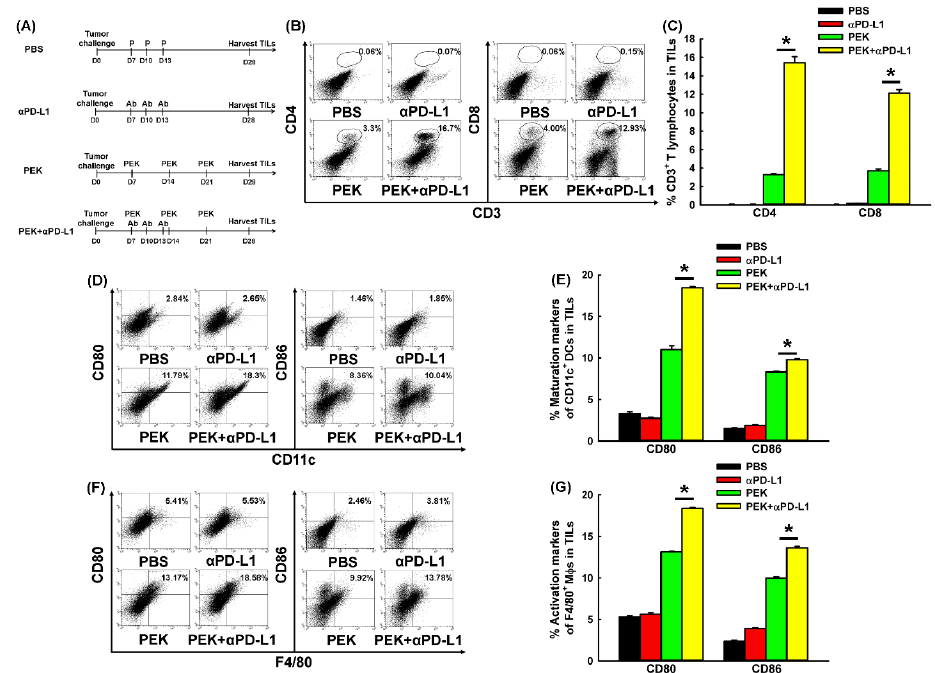
Figure 5. Alteration of T cells, DCs, and macrophages from tumor-infiltrating lymphocytes (TILs) of mice treated with PEK protein vaccine and/or anti-PD-L1 Ab. ( A ) Schematic diagram showed the obtained TILs from mice receving PEK protein vaccine with or without anti-PD-L1 Ab. ( B ) Representative figures depicting tumor-infiltrating CD4 + and CD8 + T lymphocytes from mice on day 28 after tumor challenge in various groups, as determined by flow cytometry. ( C ) Percentages of CD4 + and CD8 + T lymphocytes from mice on day 28 after tumor challenge in various groups, as determined by flow cytometry ( n = 5 per group, mean ± SEM). The percentage of CD4 + T lymphocytes was higher in tumors from mice treated with PEK protein vaccine plus anti-PD-L1 Ab than in tumors from mice treated with PEK vaccine plus PBS (*: p = 0.002, Student’s t -test). The percentage of CD8 + T lymphocytes was also higher in tumors from mice treated with PEK vaccine plus anti-PD-L1 Ab than in tumors from mice treated with PEK vaccine plus PBS (*: p = 0.002, Student’s t -test). ( D ) Representative figures of tumor-infiltrating CD80 + CD11c + and CD86 + CD11c + DCs from mice on day 28 after tumor challenge in various groups as determined by flow cytometry. ( E ) Percentages of CD80 + CD11c + and CD86 + CD11c + DCs from mice on day 28 after tumor challenge in various groups, as determined by flow cytometry ( n = 5 per group, mean ± SEM). The CD80 maturation marker of CD11c + DCs significantly increased in tumors from mice treated with the PEK protein vaccine plus anti-PD-L1 Ab compared with tumors from mice treated with the PEK vaccine plus PBS (*: p = 0.002, Student’s t -test). The CD86 maturation marker of CD11c + DCs also significantly increased in tumors from mice treated with the PEK protein vaccine plus anti-PD-L1 Ab compared with tumors from mice treated with the PEK vaccine plus PBS (*: p < 0.001, Student’s t -test). ( F ) Representative figures depicting tumor-infiltrating CD80 + F4 / 80 + and CD86 + F4 / 80 + macrophages from mice on day 28 after tumor challenge in various groups, as determined by flow cytometry. ( G ) Percentages of tumor-infiltrating CD80 + F4 / 80 + and CD86 + F4 / 80 + macrophages from mice on day 28 after tumor challenge in various groups, as determined by flow cytometry ( n = 5 per group, mean ± SEM). The percentage of CD80-expressing F4 / 80 + macrophages was significantly higher in tumors from mice treated with the PEK protein vaccine plus anti-PD-L1 Ab than in tumors from mice treated with the PEK vaccine plus PBS (*: p < 0.001, Student’s t -test). The percentage of CD86-expressing F4 / 80 + macrophages was significantly higher in tumors from mice treated with the PEK protein vaccine plus anti-PD-L1 Ab than in tumors from mice treated with the PEK vaccine plus PBS (*: p < 0.001, Student’s t -test). All experiments were performed independently in